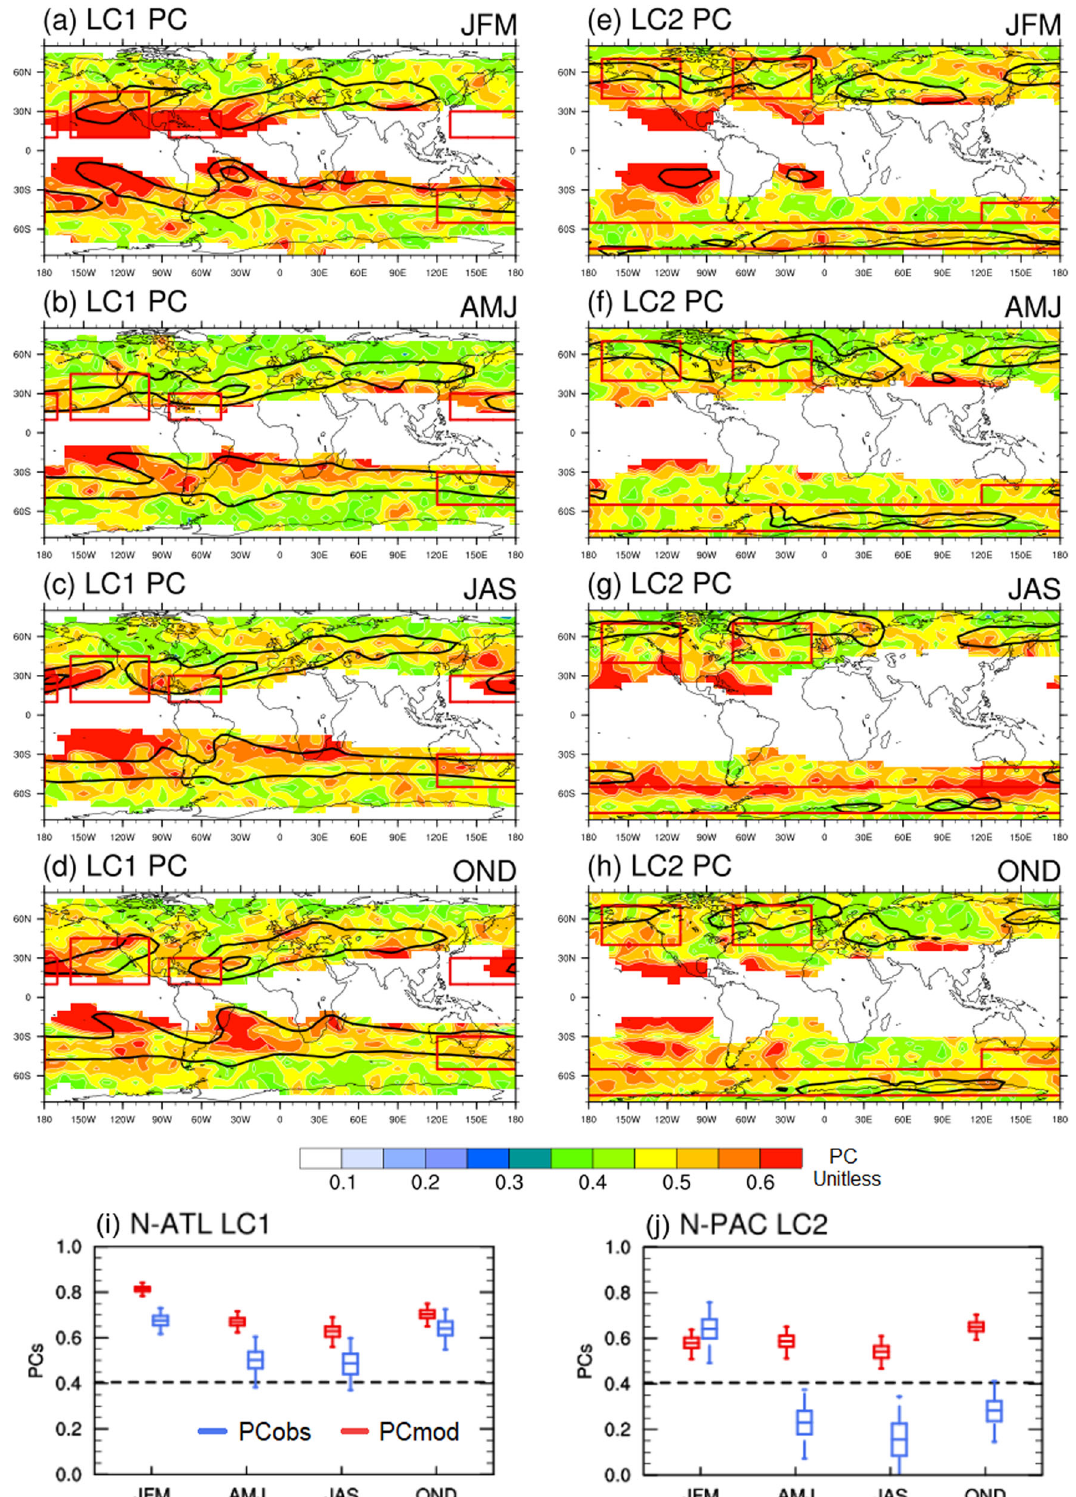
Fig. 4 Predictable components (PCs) and prediction skills of baroclinic waves in SPEAR prediction. a – d PCs of LC1 events in three-month predictions that are initialized on the 1st of January, April, July, and October of 1995 – 2018. e – h Same as ( a – d ), but for LC2 events. i PCs (red) and prediction correlation skills (blue) of the N-ATL LC1 events for the four above initialization months. j Same as ( i ), but for N-PAC LC2 events. The other plot settings are the same as in Fig.